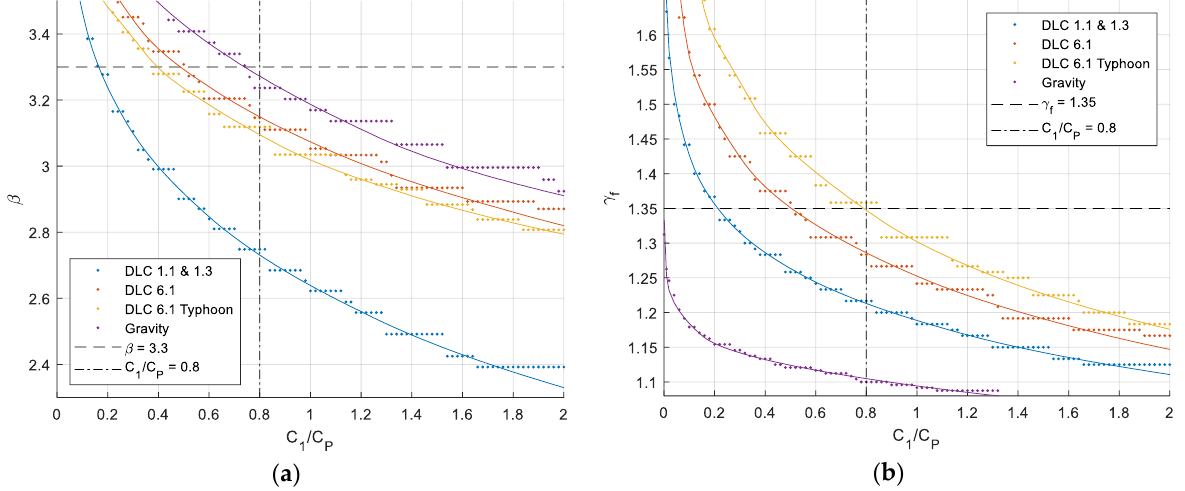
Figure 6. The optimal value of ( a ) annual reliability index (in the first year), ( b ) load safety factor for γ = 0.12. The dots correspond to optimal values of the design parameter among the ones where reliability analyses were performed, and the lines are obtained by using a cubic smoothing spline on the expected profit Z(z) and then finding the optimal on that spline.